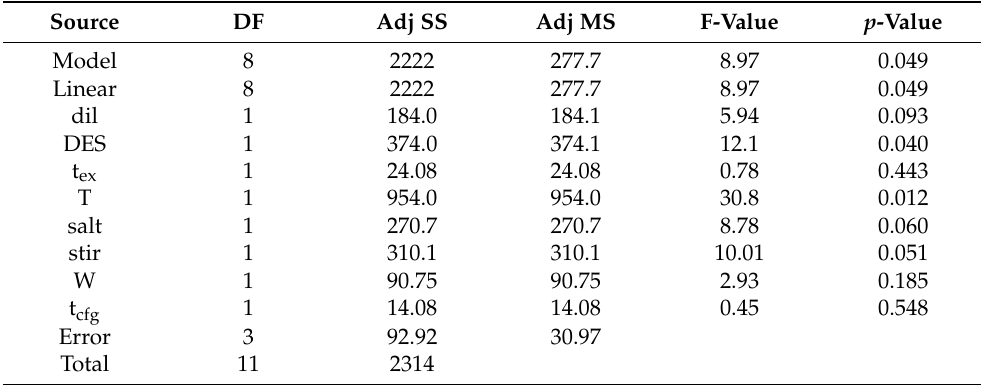
Table 2. ANOVA results from the Plackett–Burman (PBD) design.